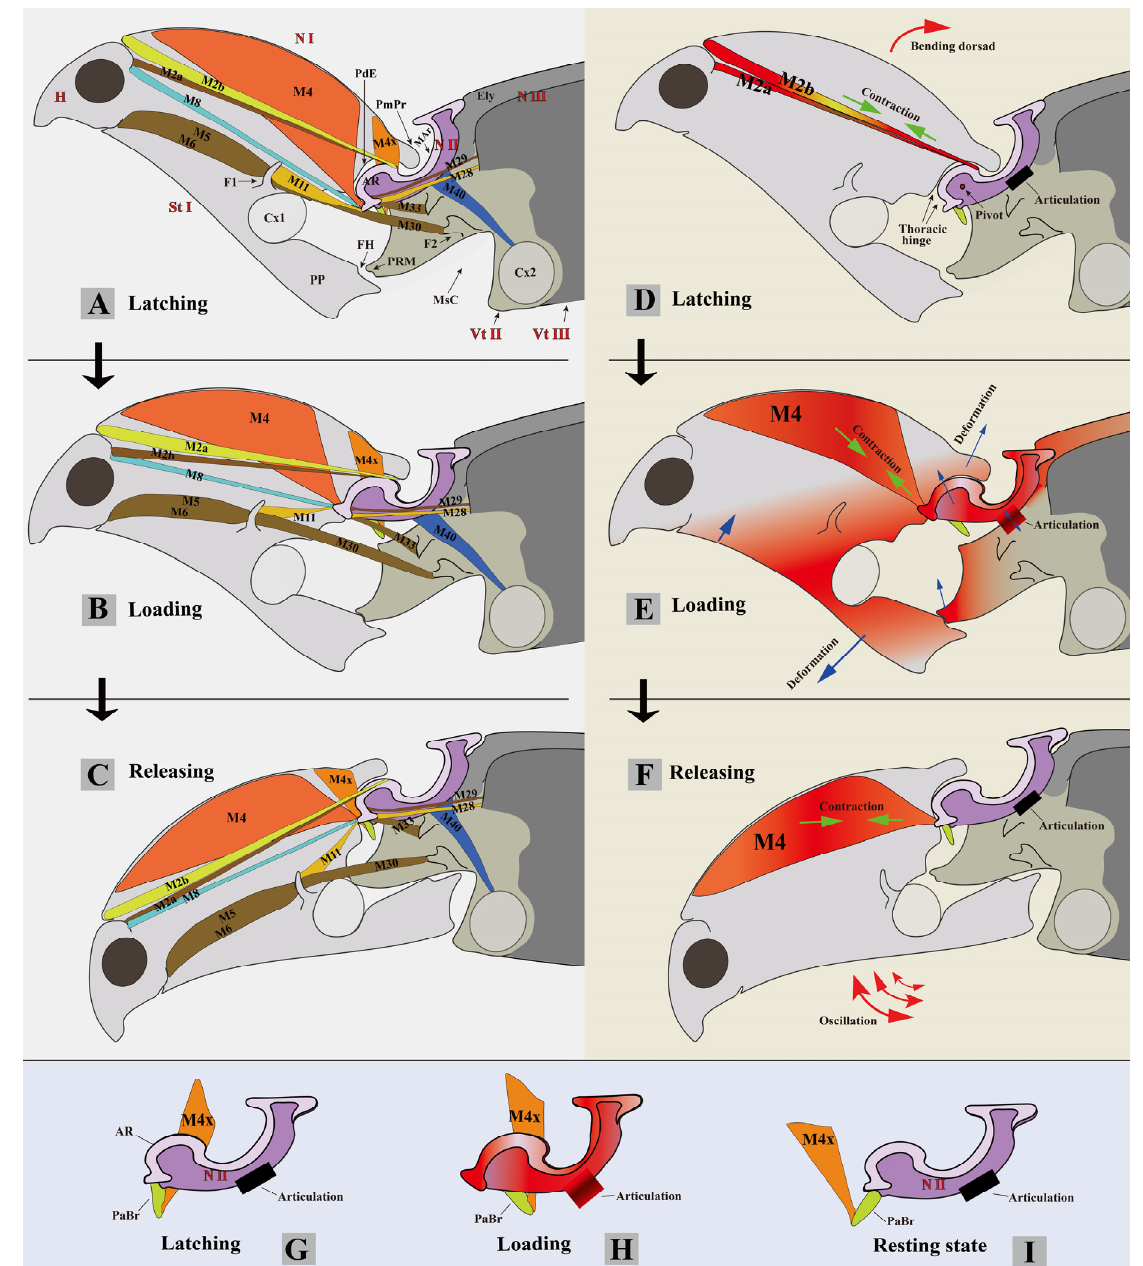
Figure 13. A diagram of the clicking mechanism and the deformation of thoracic structures in Campsosternus auratus . ( A – C ) show the major skeleton and muscles in the pro- and mesothorax. ( D – F ) show the contraction of muscles and the deformation of thoracic structures in the clicking process; the tension in the thoracic structures is indicated with a red gradient color; blue arrows show the deformation of skeleton; green arrows show the contraction of M2 and M4; and black and red rectangles indicate the articulation between the mesonotum and mesopleuron. ( A , D ) latching phase: red arrow shows the back-arching movement of the prothorax when muscles M2a and M2b contract. ( B , E ) loading phase: the enormous M4 contracts, to load the biological springs. ( C , F ) releasing phase: biological springs release the elastic energy stored in the previous phase. ( G – I ) the shape of the mesonotum in different stages (latching, loading, and resting): the mesonotum is in its original form in the resting and latching phases, and bent dorsad in the loading phase. ( G – I ) also show that the prealar bridge is significantly pulled posterad in the loading phase when M4x